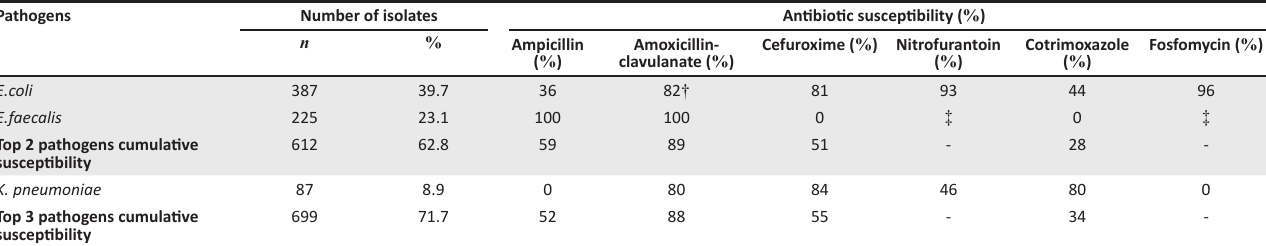
TABLE 2: Cumulative coverage for top